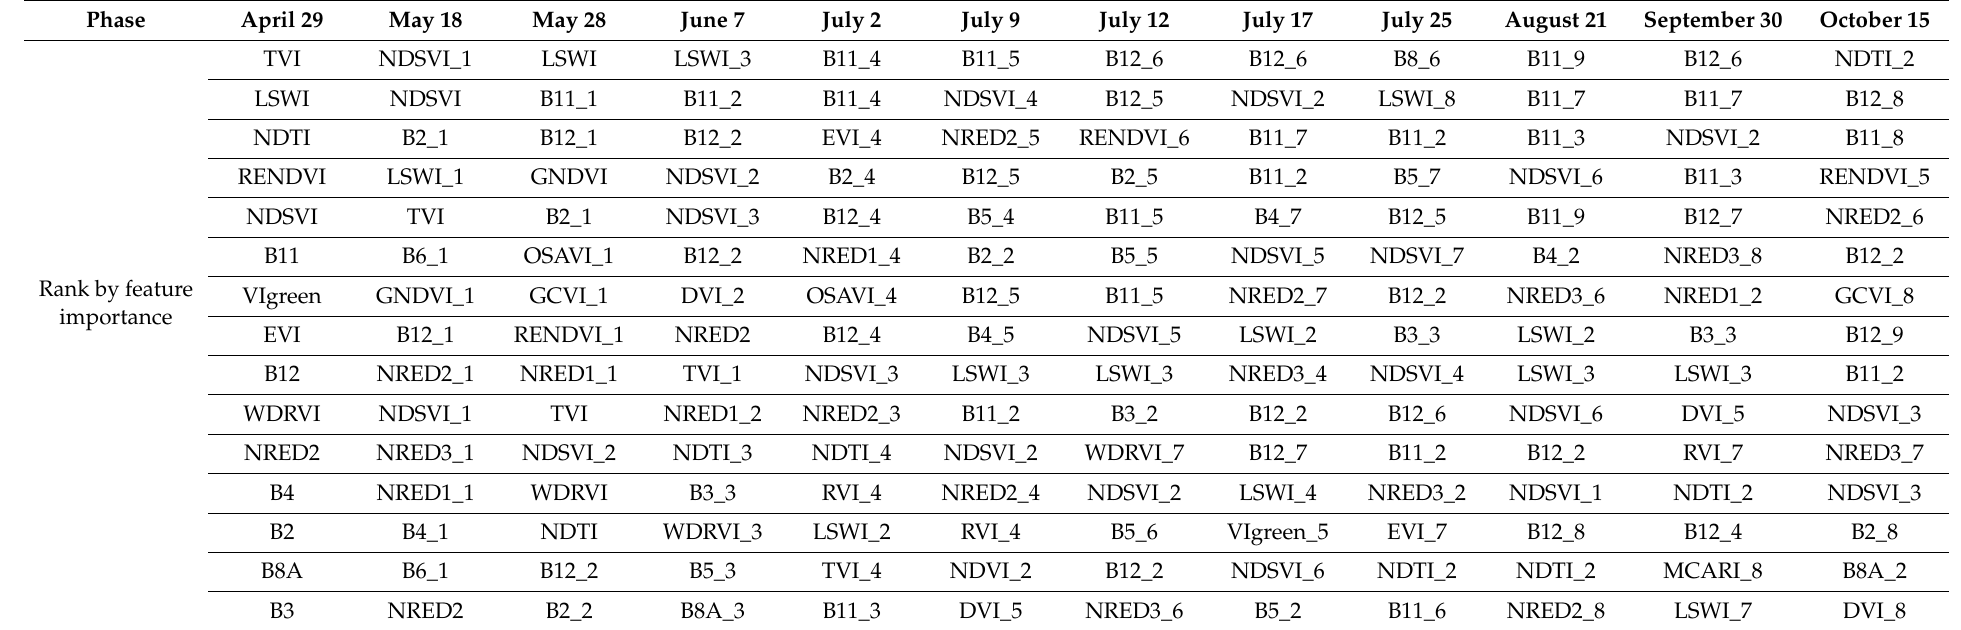
Table A2. Optimal feature sets at different periods in Region